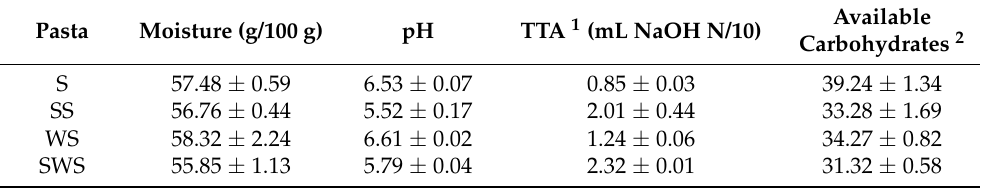
Table 1. Chemical properties of cooked